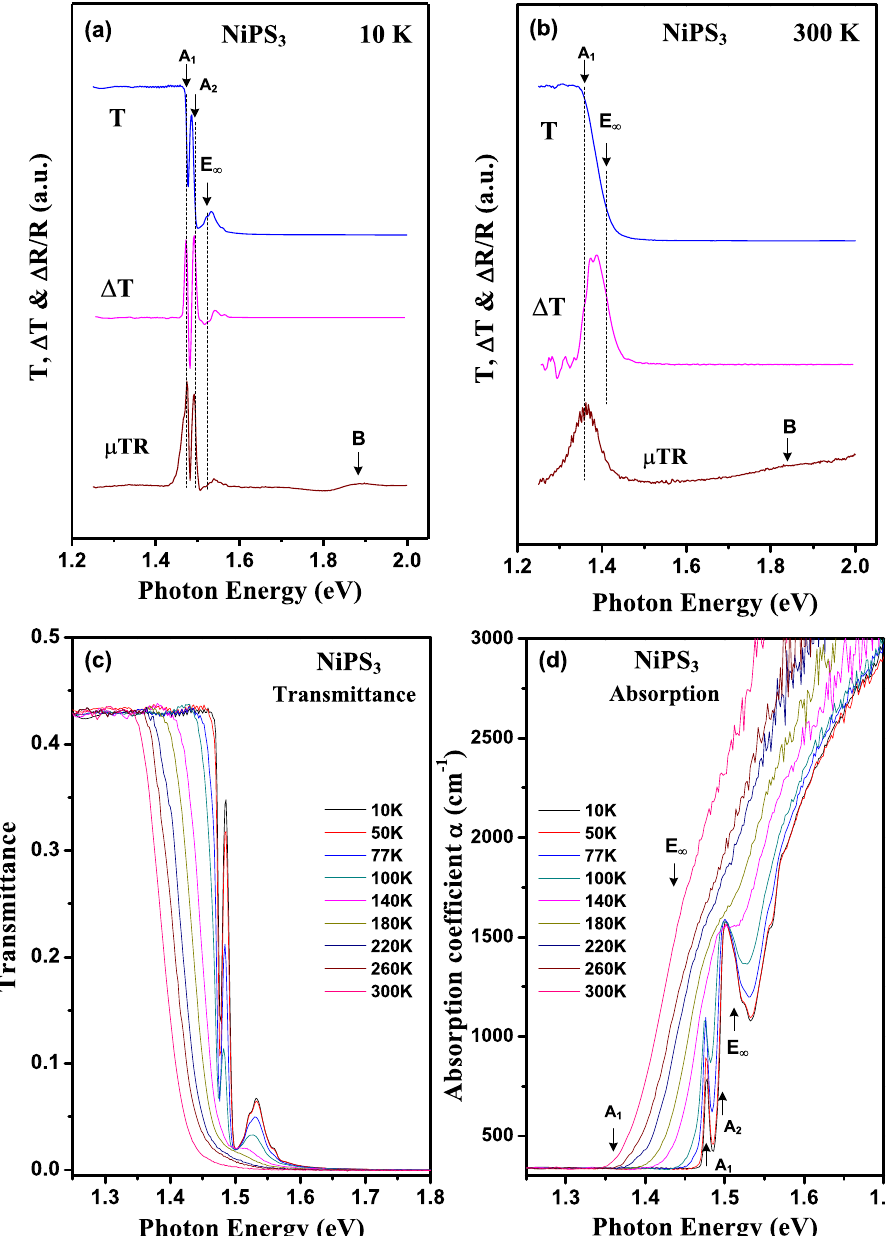
Fig. 4 The comparison of transmittance and μ TR spectra in NiPS 3 . Spectral comparison of the band-edge transitions in the transmittance ( T ), fi rst-derivative transmittance ( Δ T ), and μ TR spectra at a 10 K and b 300 K. The temperature-dependent transmittance and absorption spectra of the layered NiPS 3 sample from 10 to 300 K are shown in c and d ,